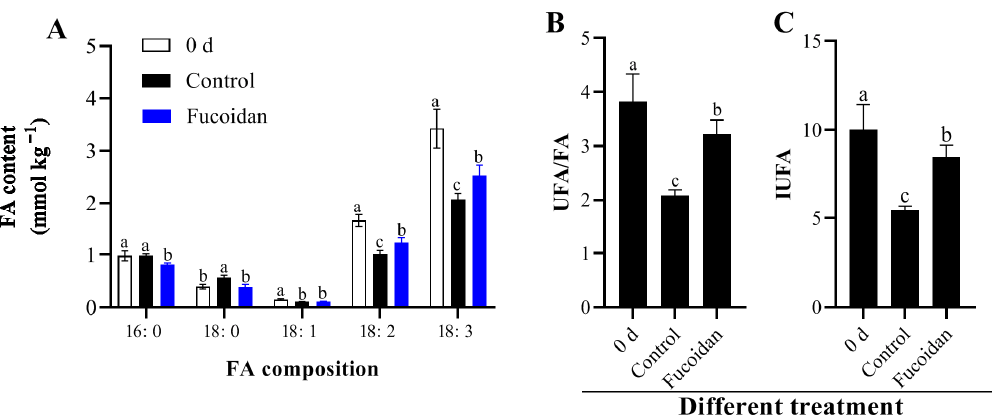
Figure 2. Contents of FA composition ( A ), UFA/FA ratio ( B ), and IUFA ( C ) in cucumber fruit at harvest (0 day) and in fucoidan-treated and control fruit after 12 d of storage at 4 °C. Values are marked as mean ± standard deviation (SD) of three replicates. Bars with same letter mean no significant differences at p < 0.05.